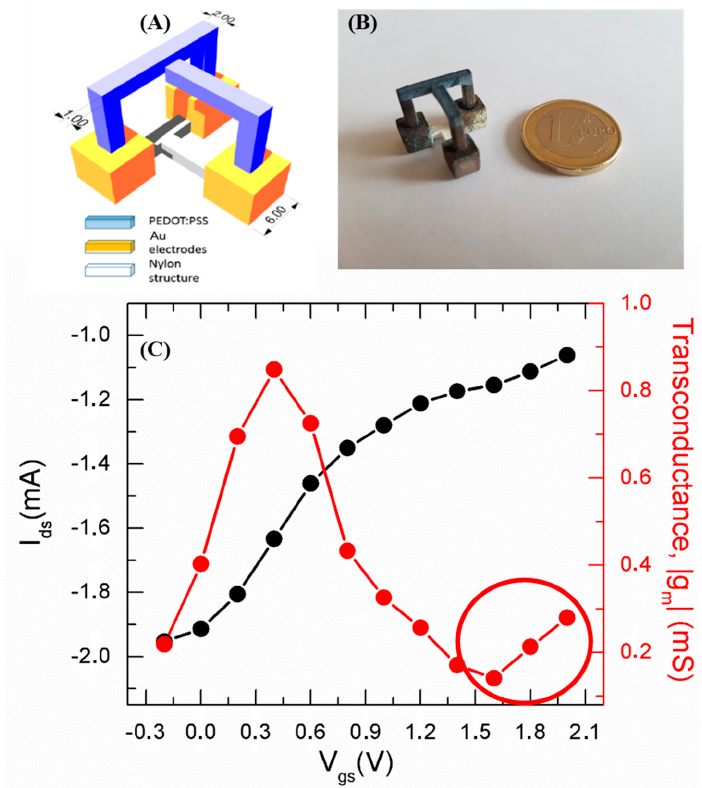
Figure 1. ( A ) Scheme of the designed 3D device (units are expressed in mm); ( B ) optical image of the fabricated 3D device; ( C ) organic electrochemical transistor (OECT) operation: transfer curve (black line-symbols) and related transconductance curve (red line-symbols) recorded by sweeping V gs between − 0.2 V and 2